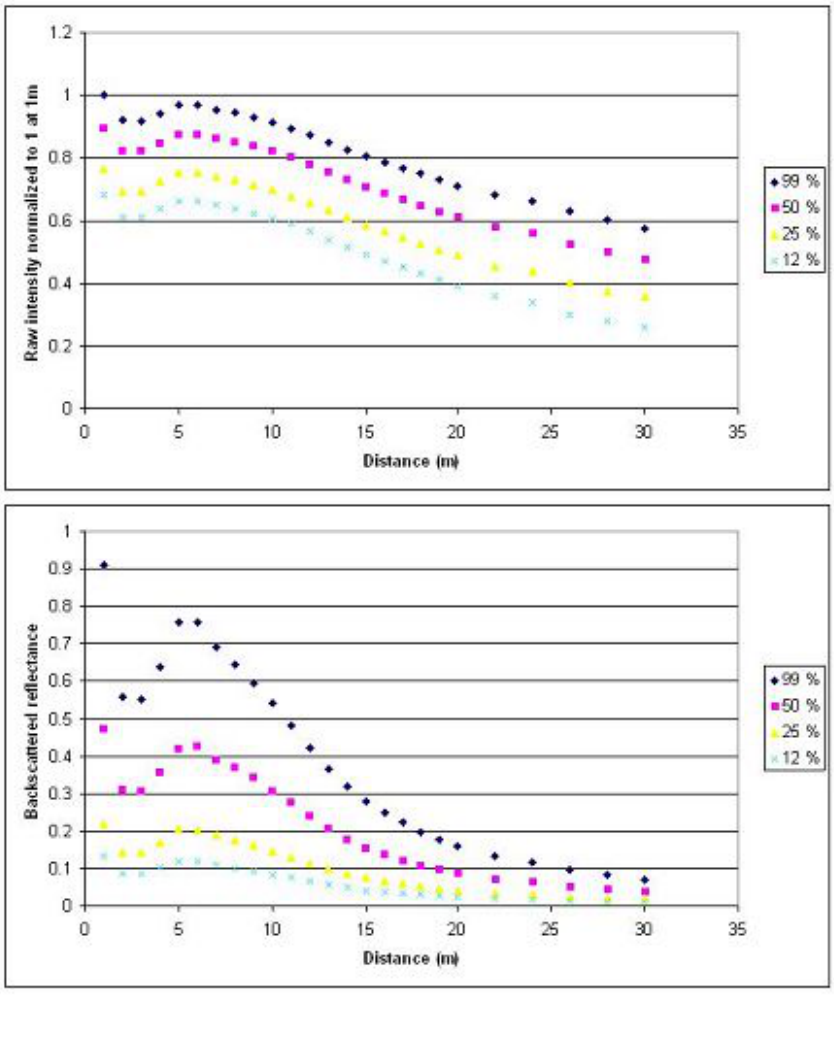
Figure 3. FARO: 2007 distance measurement, no logarithmic calibration of the amplifier, relative to the raw intensity of the 99% Spectralon at 1 m distance (top panel). The same (2007) measurement with logarithmic calibration, and normalised with 99% Spectralon at 1 m distance (lower panel).